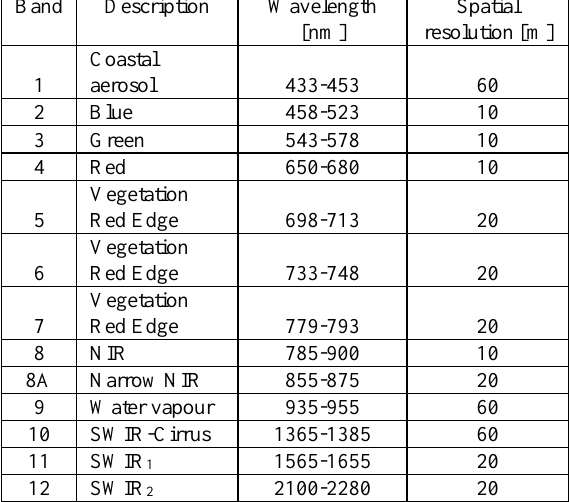
Table 1. Sentinel-2 bands with original spatial resolution prior to